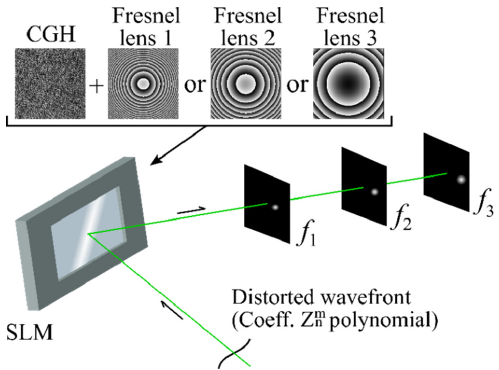
Figure 2. Functional scheme of the modified wavefront measurement algorithm operating principle .